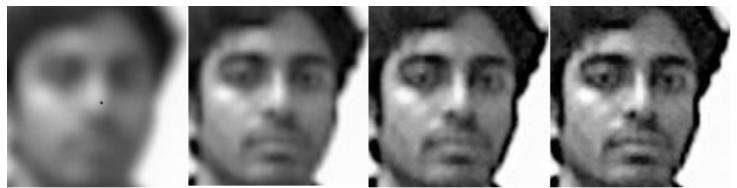
Figure 10. An example of image rendered at different focus levels: The pictures are all extracted from the same light-field image. Image from the GUCLF